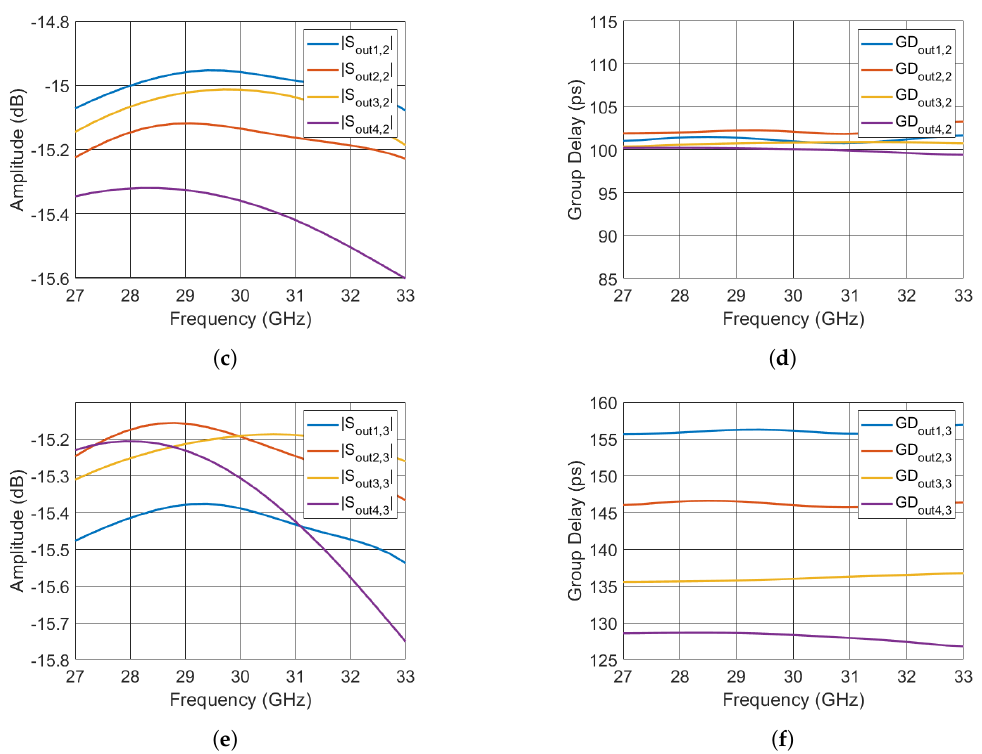
Figure 19. Proposed Blass matrix simulation results: ( a , c , e ) amplitudes | S ij | for the i = 1–4 outputs when the input ports j = 1,2,3 are excited; and ( b , d , f ) group delay for the i = 1–4 outputs when input ports j = 1,2,3 are excited.